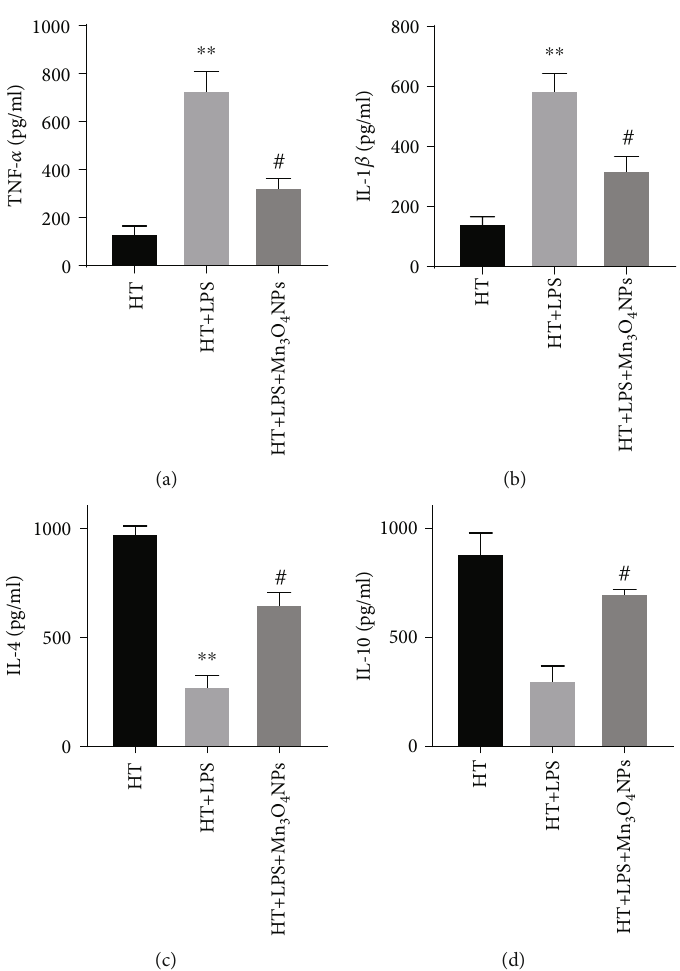
Figure 2: E ff ects of Mn O nanoparticles on the in fl ammatory factors levels in human tendon cells induced by LPS. (a) TNF- α level measured 3 4 by ELISA. (b) IL-1 β level measured by ELISA. (c) IL-4 level measured by ELISA. (d) IL-10 level measured by ELISA. ∗∗ P < 0 : 01 vs. HT group; # P < 0 : 05 vs. HT+LPS